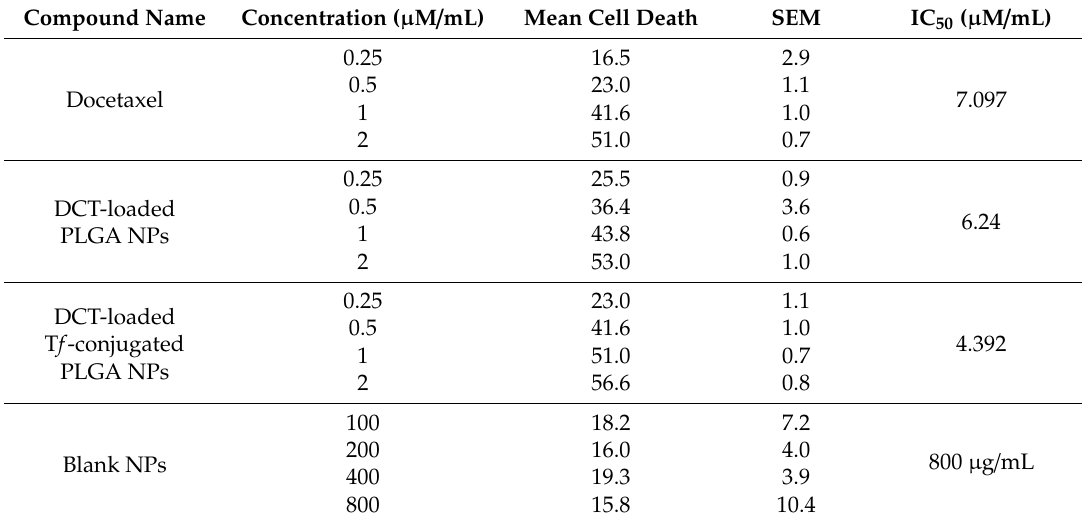
Table 6. In vitro cytotoxicity assay in MCF-7 cell